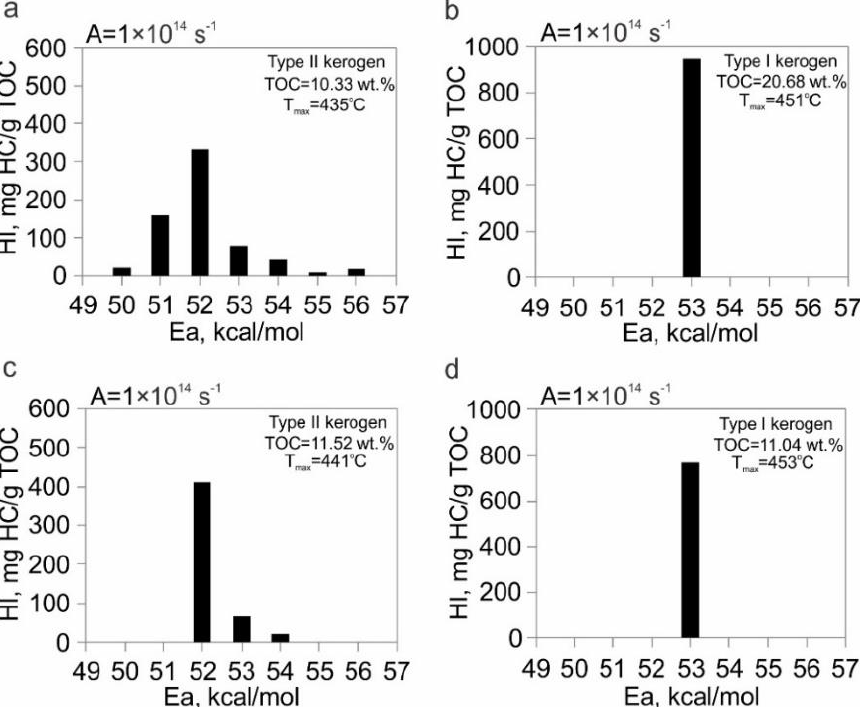
Figure 8. Activation energy distribution of organic matter thermal decomposition for the host rocks ( a , c ) and for the alginite-rich layers ( b , d ). Frequency factor A is fixed to 1 × 10 14 s −1 .